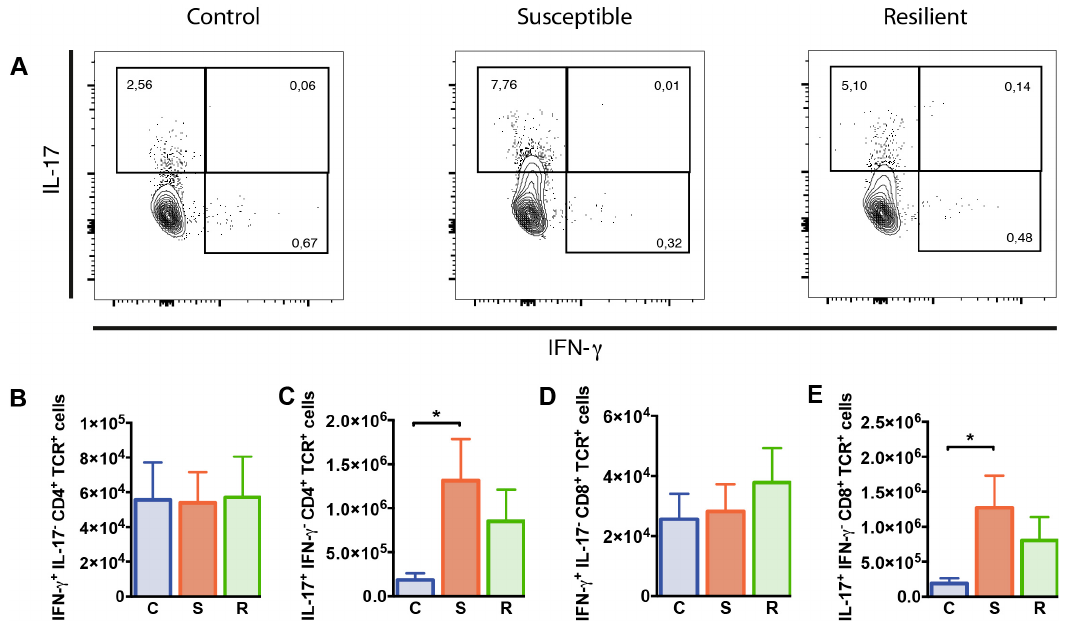
Figure 4. Cytokine expression by CD4 + and CD8 + T cells from the spleen of mice after social defeat. Representative contour plots showing expression of ( A ) IFN- γ and IL-17 in CD4 + T cells from the spleen as determined by flow cytometry. ( B ) Numbers of IFN- γ and ( C ) IL-17 producing CD4 + T cells.